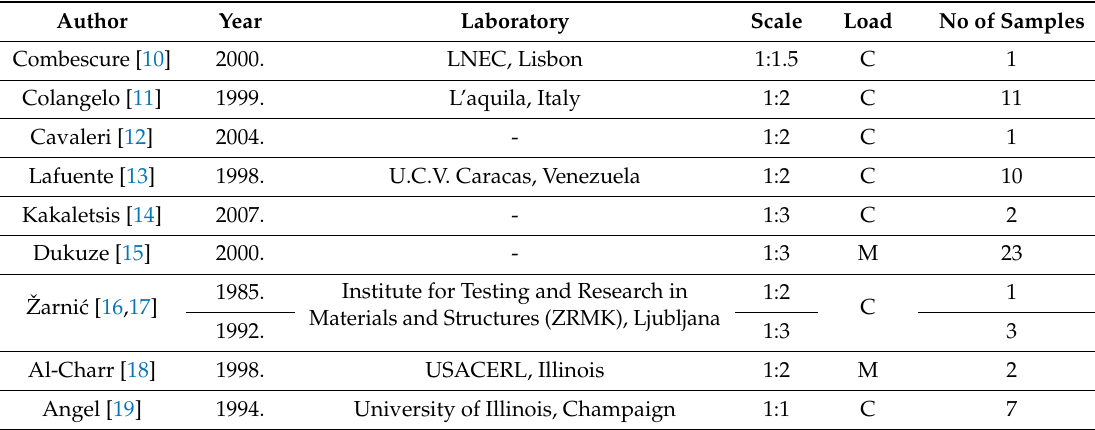
Table 1. Experimental database: authors and samples